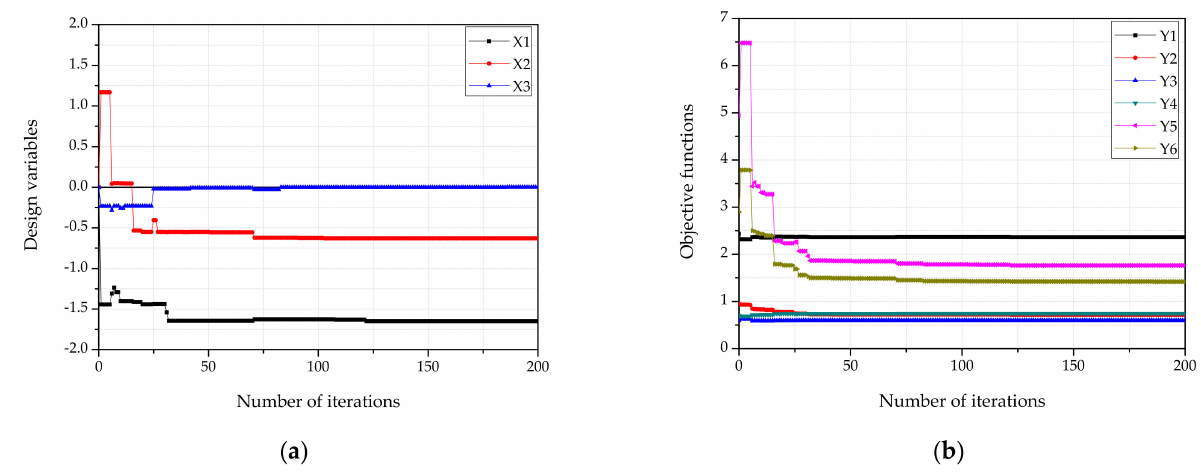
Figure 13. Convergence history plot: ( a ) design variables; ( b ) object functions.